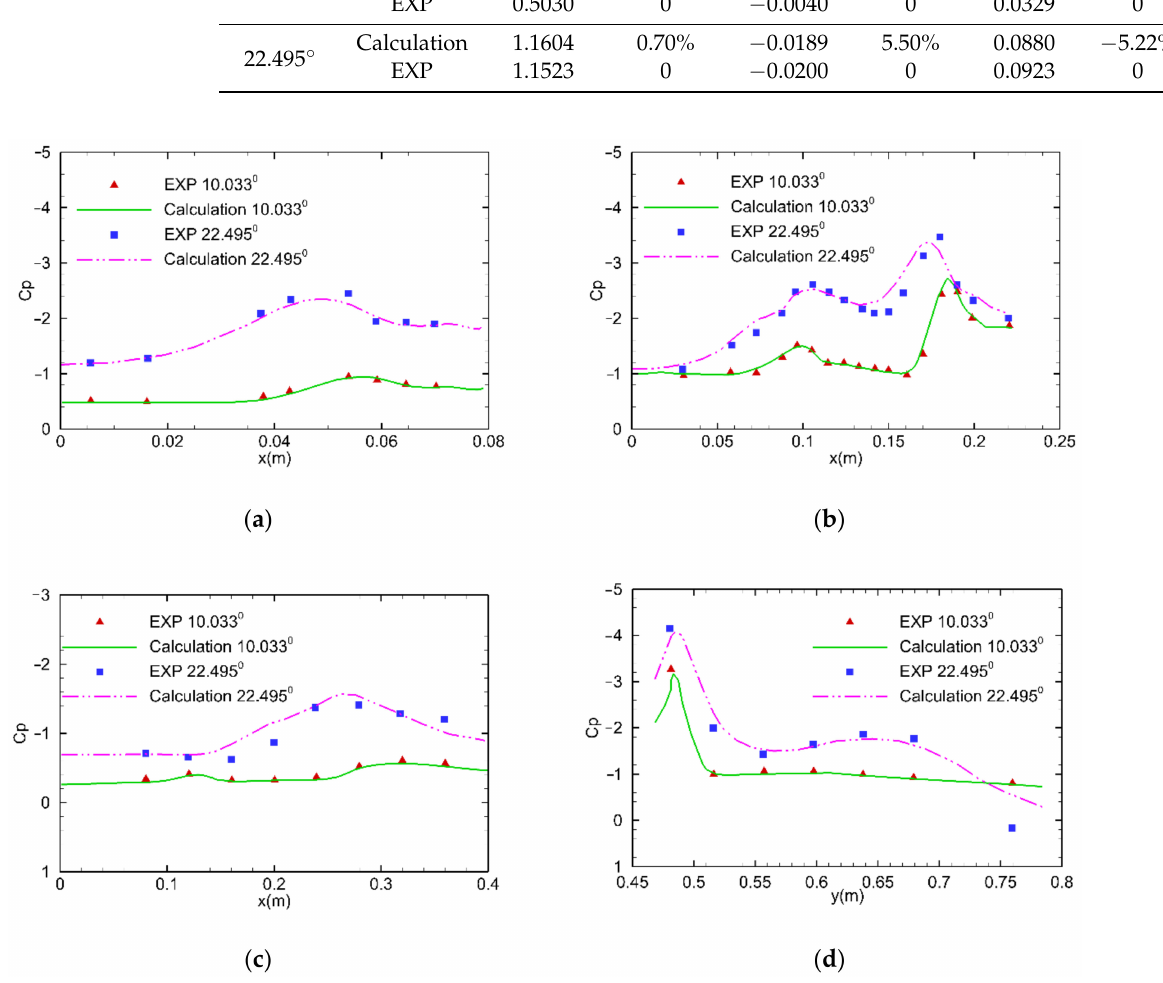
Figure 3. Pressure coefficients comparisons of the experiment [24] and numerical calculation on the upper surface of LSSDW at typical sections for Ma = 0.225, Re = 3.7 × 10 6 : ( a ) Section 1; ( b ) Section 2; ( c ) Section 3; ( d ) Section